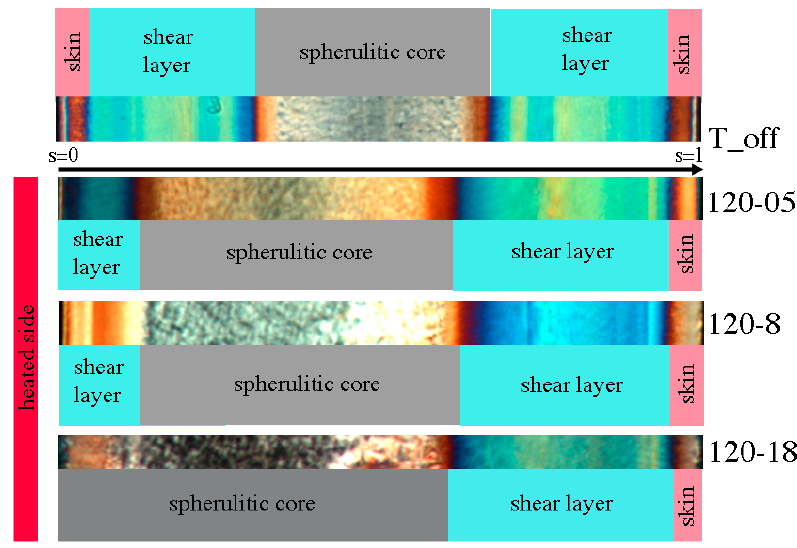
Figure 4. Optical micrographs of the samples from test runs T_off, 120-05, 120-8 and 120-18. The heated side is reported on the left most of the figure.